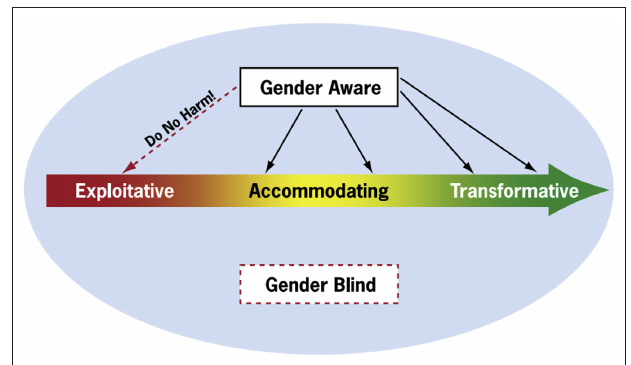
FIGURE 1 | A diagram of the USAID Gender Continuum Tool designed for the ASSIST project. The tool defines each level of gender awareness on a continuum to help individuals or organizations identify not only where they fall on the continuum currently but how to reach the goal of gender transformative behaviors and policies. Source: Interagency Gender Working Group